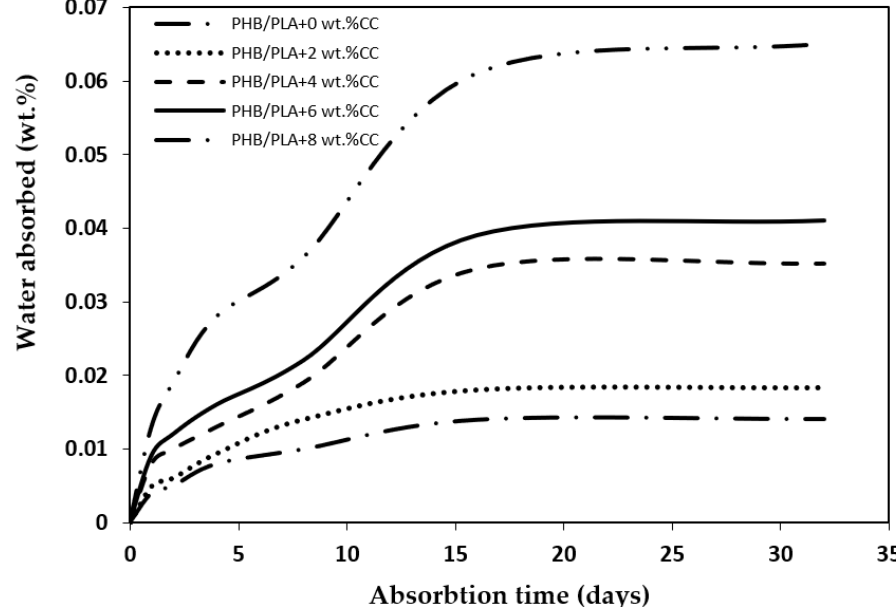
Figure 14. Effect of filler loading on water absorption of PHB/PLA corncob composites.